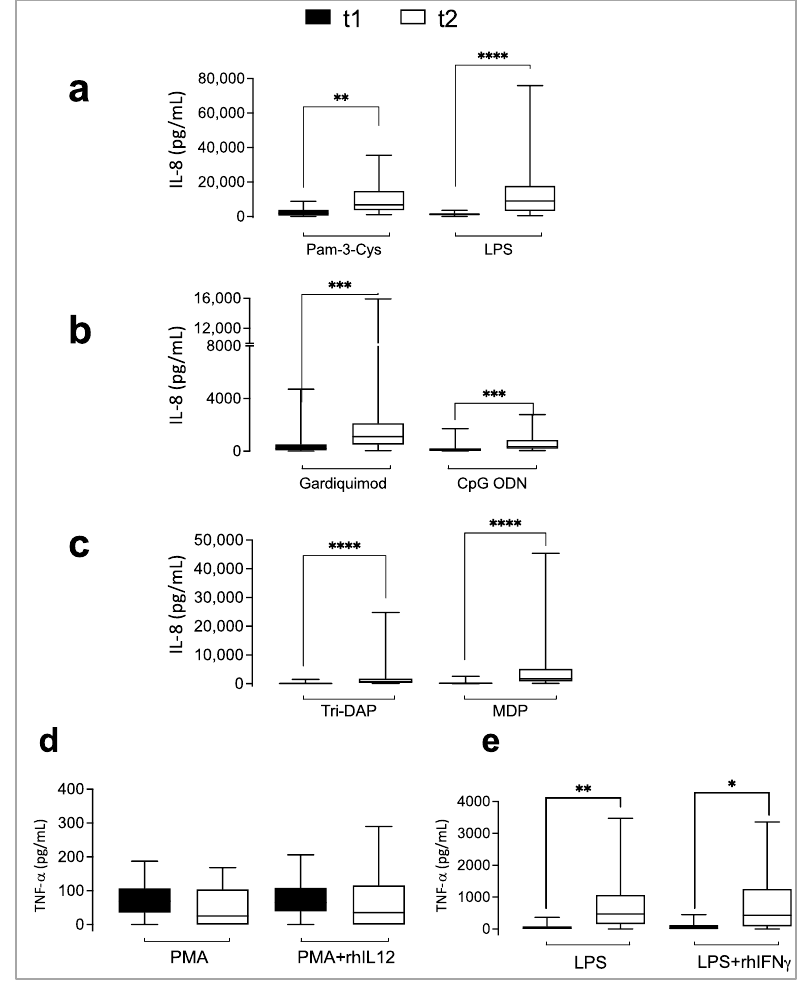
Figure 3. Immune receptors are functional in critically ill COVID-19 patients two weeks after admission. Whole blood diluted 1:1 with culture medium was stimulated with specific ligands of innate ( a – c ) and adaptive ( d , e ) immune receptors, as described in Materials and Methods. Depicted are box plots and pairwise comparisons between t1 (at admission) and t2 (two weeks later during hospitalization). * p < 0.05, ** p < 0.01, *** p < 0.001, **** p < 0.0001.